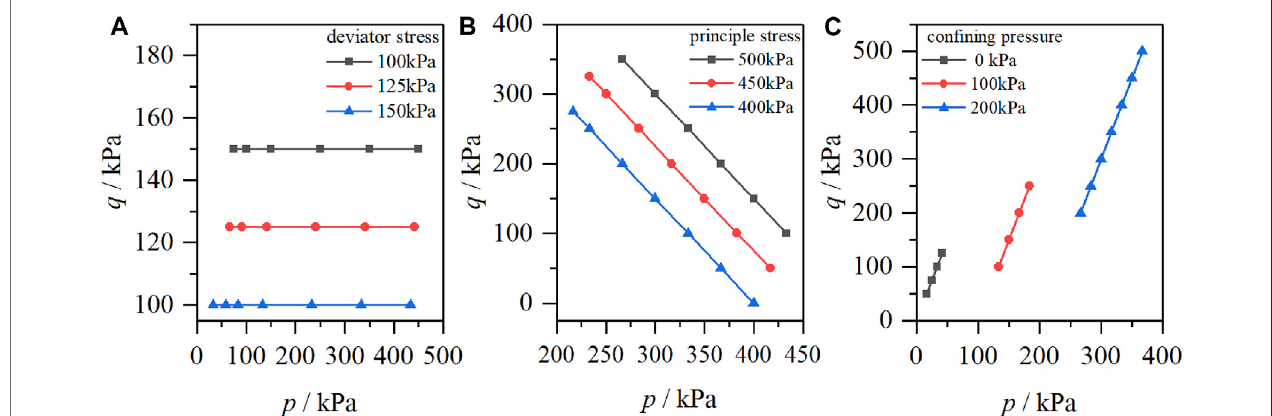
FIGURE 2 | Stress path of the testing